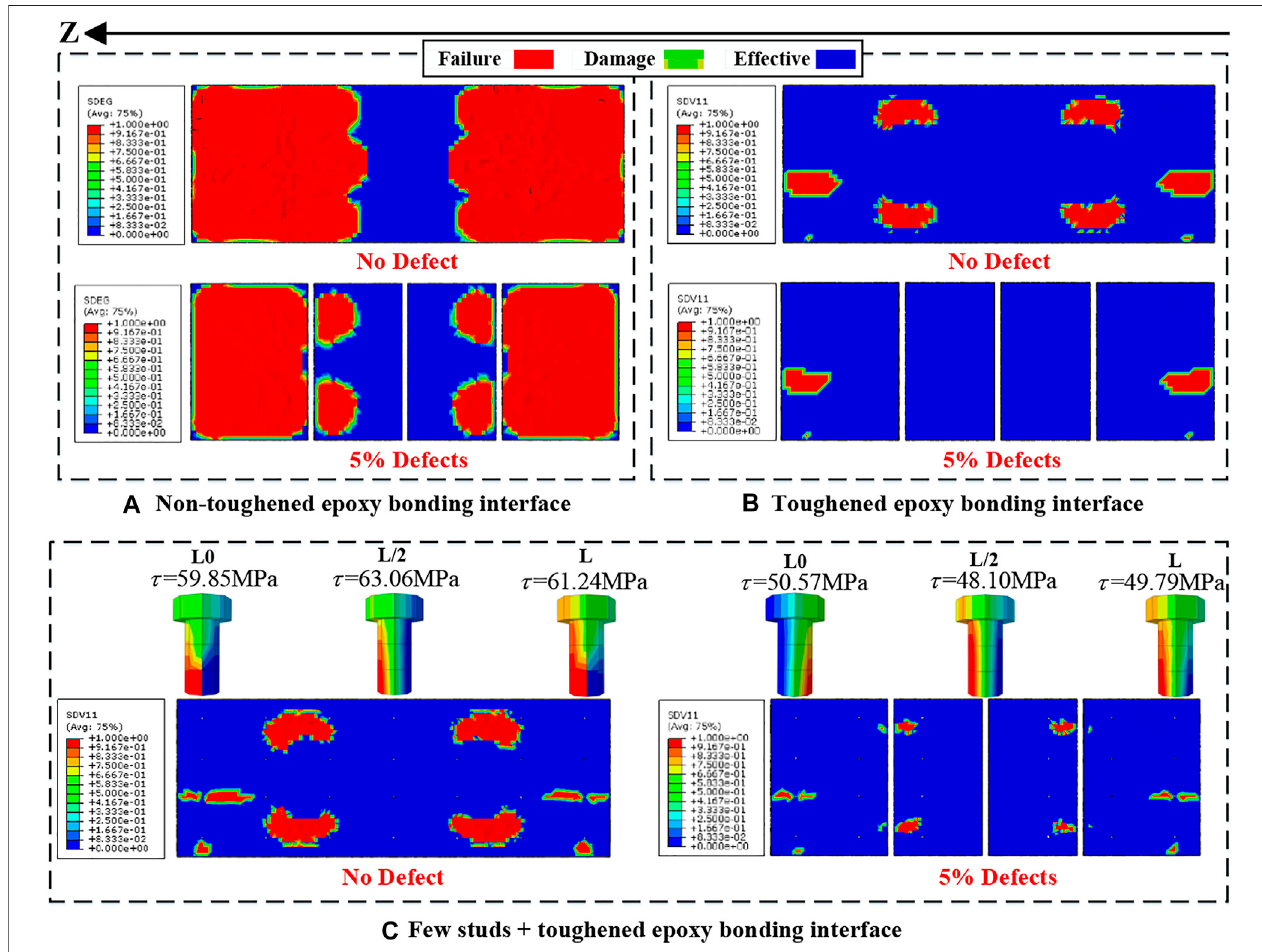
FIGURE 15 | Stress distribution before and after interface defects under the overload wheel load. (A) Non-toughened epoxy bonding interface. (B) Toughened epoxy bonding interface. (C) Few studs + toughened epoxy bonding interface.